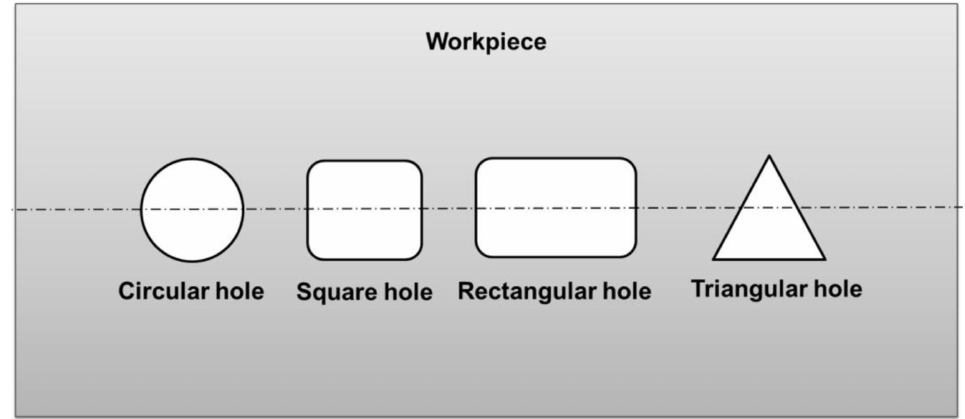
Figure 2. Types of holes that can be fabricated by the micro-spark-erosion machining ( µ -SEM)